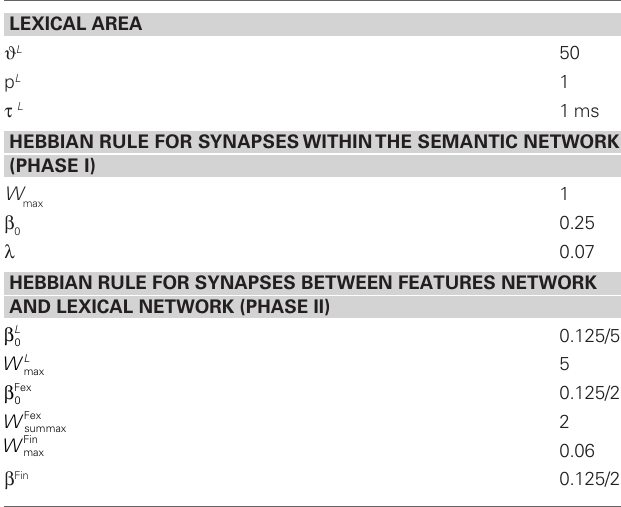
Table 2 | Model parameters used during the